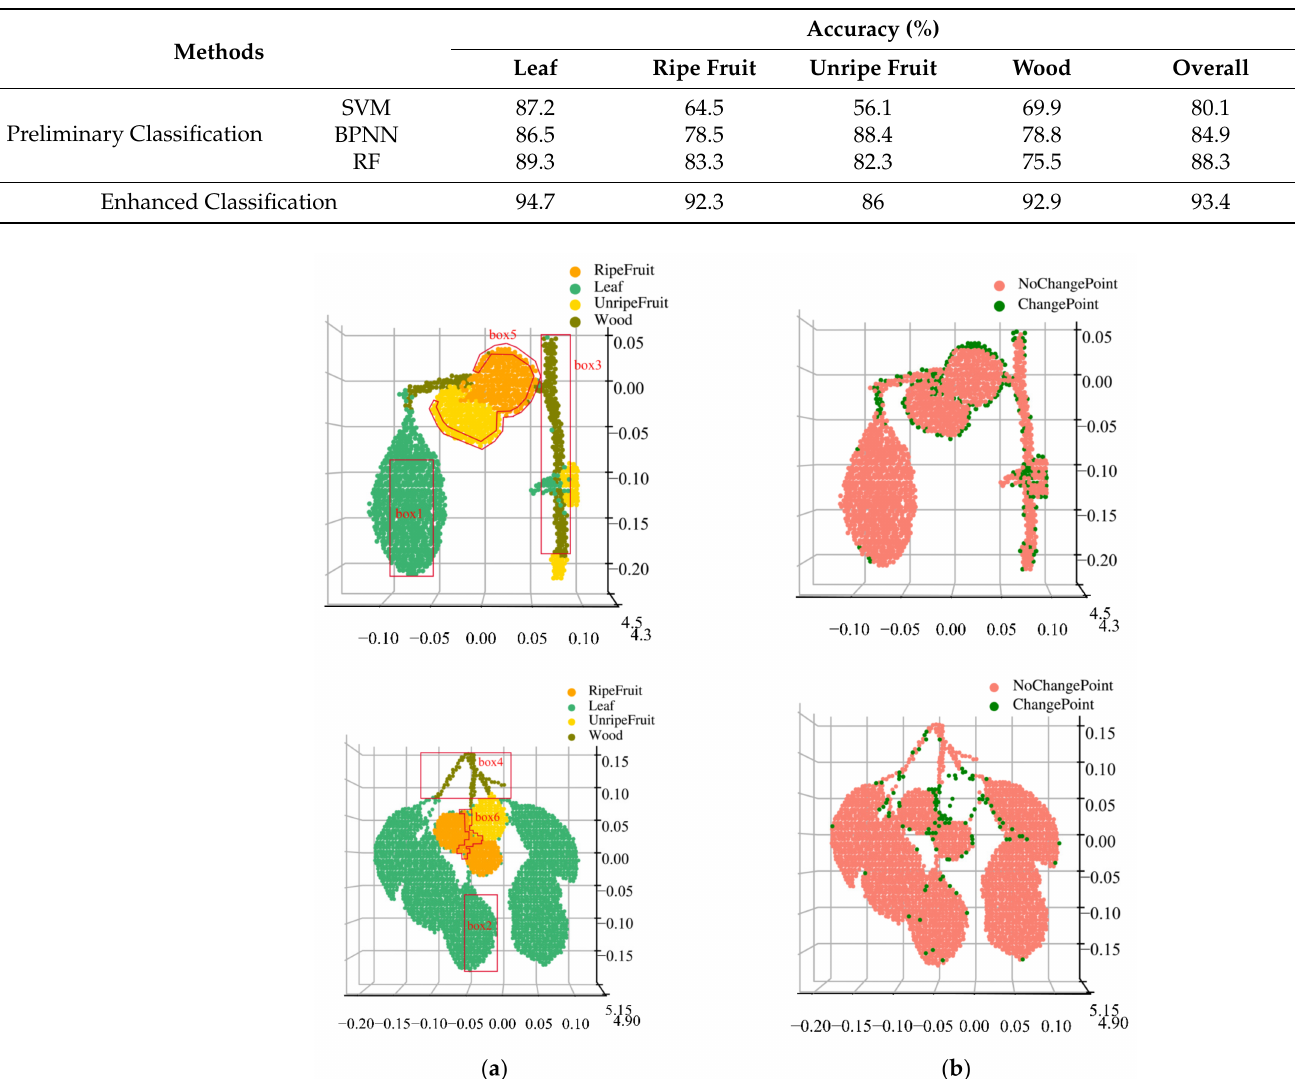
Table 5. Comparison of classification accuracy of the lemon sample.